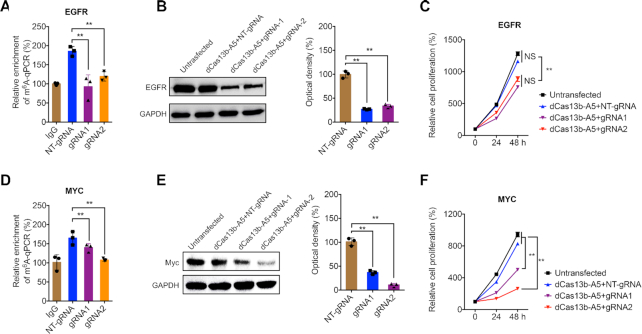
Targeting m6A of oncogene transcripts by dm6ACRISPR regulates cell proliferation. (A) m6A RIP-qPCR analysis of EGFR mRNA in HeLa cells transfected with dCas13b-ALKBH5 combined with NT-gRNA or gRNA1/2, respectively, for 24 h; (B) Protein expression of EGFR in HeLa cells untransfected or transfected with dCas13b-ALKBH5 combined with NT-gRNA or gRNA1/2, respectively, for 24 h, and checked by western blot analysis (left) and quantitatively analyzed (right); (C) Proliferation of HeLa cells untransfected or transfected with dCas13b-ALKBH5 combined with NT-gRNA or gRNA1/2, respectively, for the indicated time periods; (D) m6A RIP-qPCR analysis of MYC mRNA in HeLa cells transfected with dCas13b-ALKBH5 combined with NT-gRNA or gRNA1/2, respectively, for 24 h; (E) Protein expression of MYC in HeLa cells untransfected or transfected with dCas13b-ALKBH5 combined with NT-gRNA or gRNA1/2, respectively, for 24 h, and checked by western blot analysis (left) and quantitatively analyzed (right); (F) Proliferation of HeLa cells untransfected or transfected with dCas13b-ALKBH5 combined with NT-gRNA or gRNA1/2, respectively, for the indicated time periods. Data are presented as mean ± SD from three independent experiments. ** P < 0.01, NS, no significant, by one-way ANOVA with Bonferroni test.